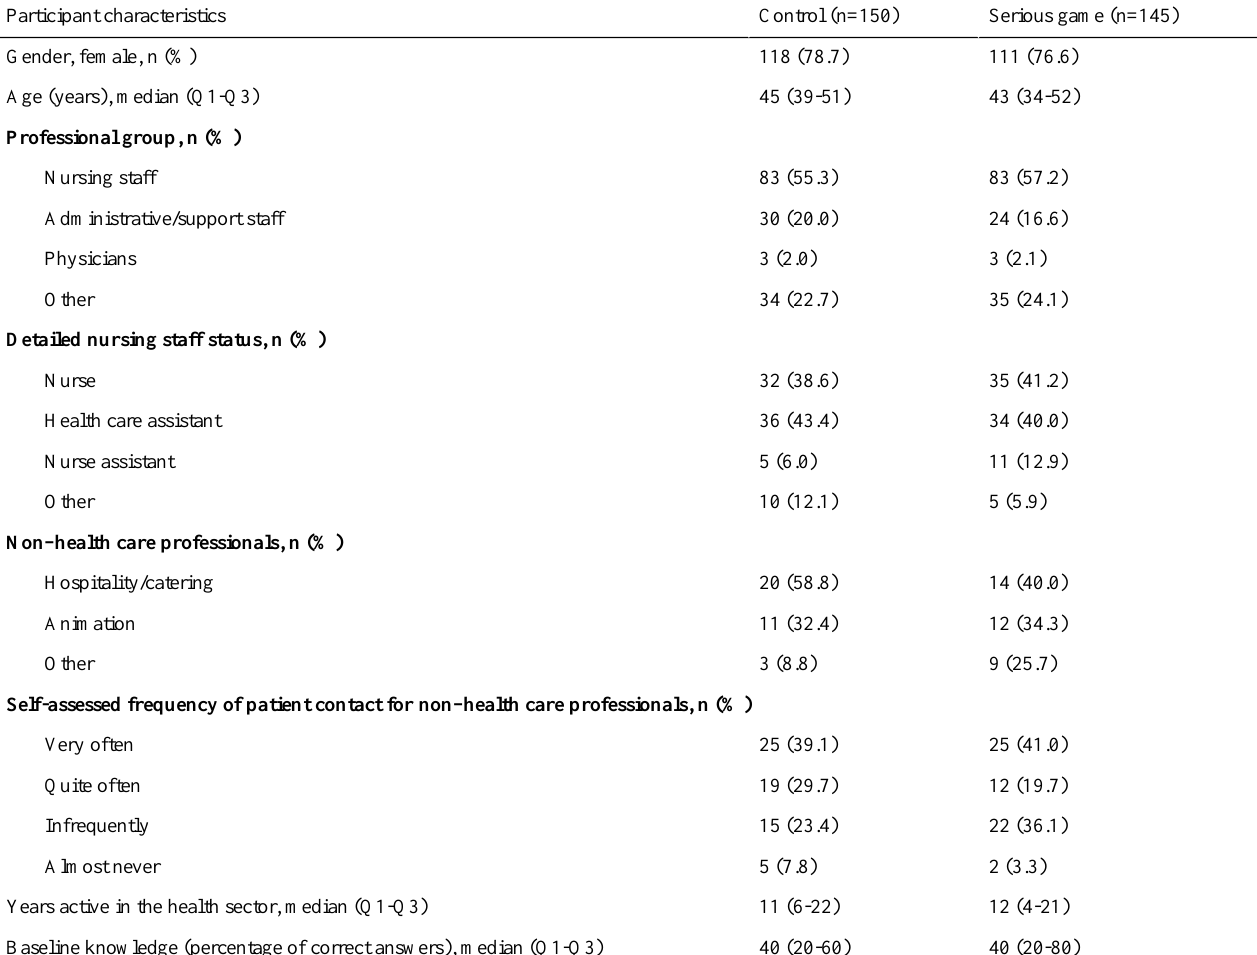
Table 1. Participant characteristics from 36 long-term care facilities in Geneva, Switzerland. Totals may not equal 100% due to